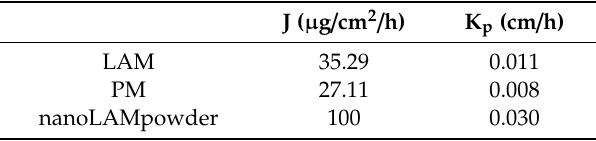
Table 2. The calculated Flux (J) and the permeability coe ffi cient (K p ) values.